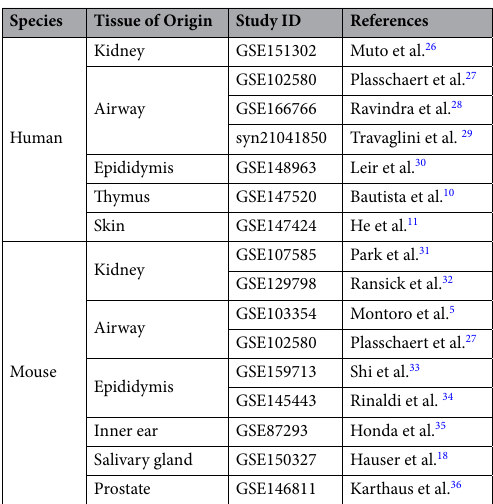
Table 1. List of single-cell RNA sequencing datasets used in this